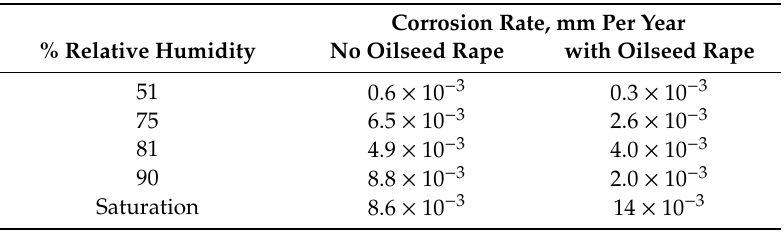
Table 7. Relationship between relative humidity, rapeseed oil, and corrosion of silos [11]. “Reproduced with permission from Cleland, J.H., Eng. Fail. Anal. by Elsevier, 1994.”